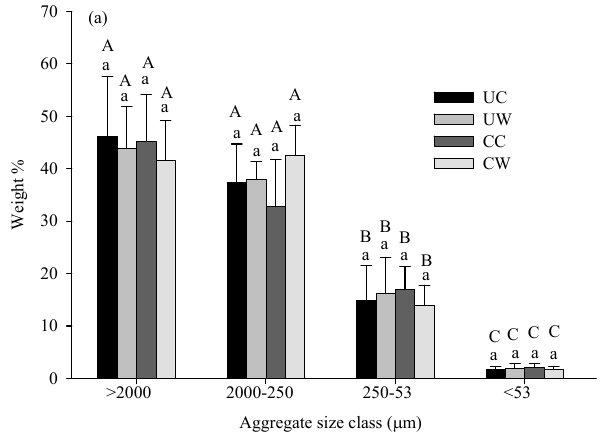
Fig. 1. Weight distribution among aggregate size classes under four treatments after nine years of warming and clipping. Values followed by a different lowercase letter are significantly different within aggregate size classes among treatments. Values followed by a different capital letter are significantly different among aggre- gate size classes under treatments. Abbreviations: UC, unclipped control; CC, clipped control; UW, unclipped warming; CW, clipped warming.